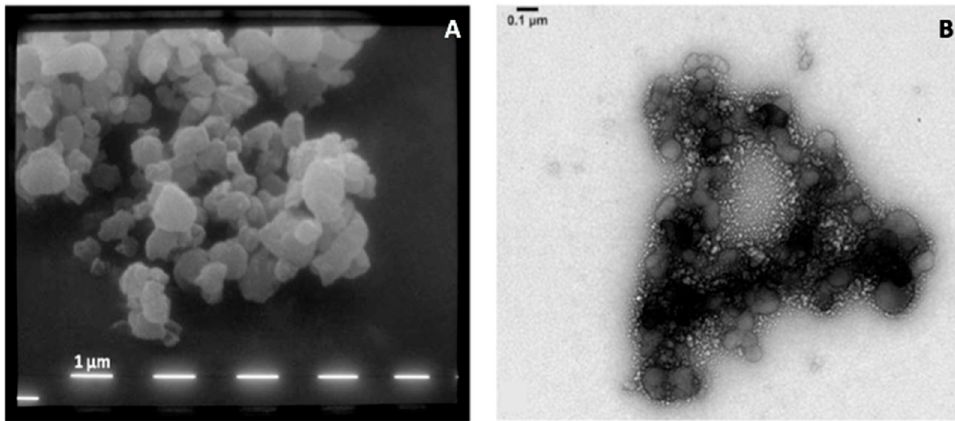
Figure 6. SEM ( A ) of the microparticles constituting the powder and TEM ( B ) pictures of the nanoparticles agglomerated to form the microparticles.